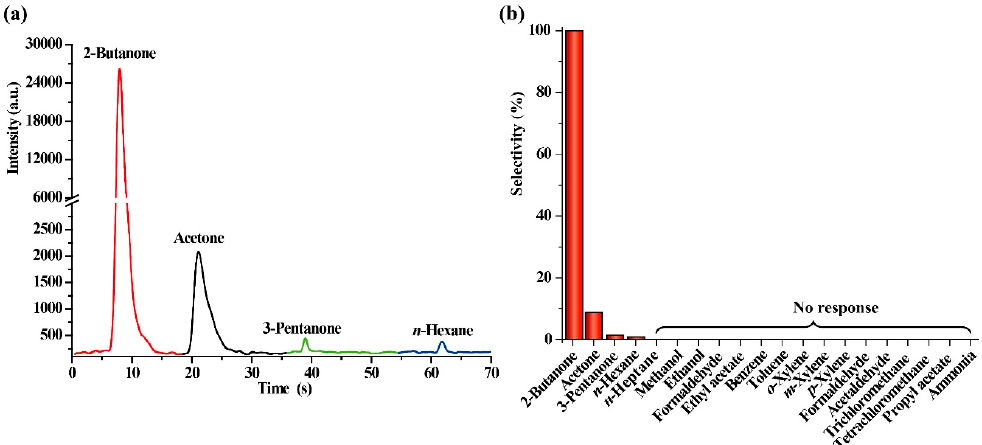
Figure 5. ( a ) The dynamic response curves of 2-butanone, acetone, 3-pentanone and n -hexane on nanosized V 2 O 5 surface. ( b ) The selectivity of 2-butanone sensor based on nanosized V 2 O 5 . Wavelength: 440nm, temperature: 231 ◦ C, flow rate: 220 mL / min, the concentration of all gases is 200 mg / m 3 .